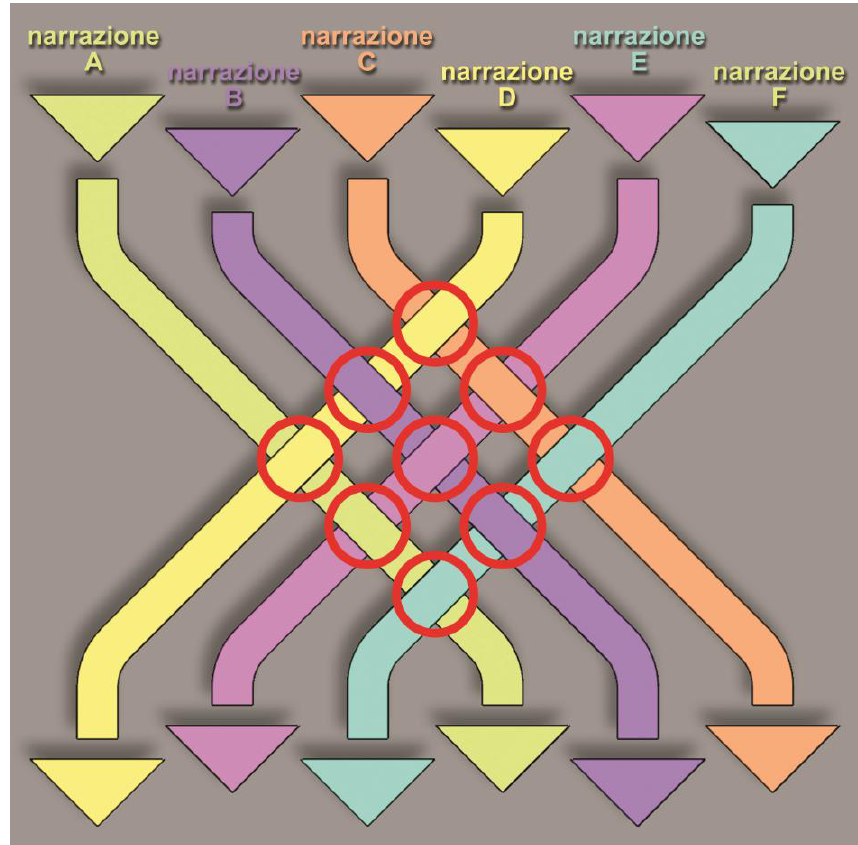
Figure 2. The diagram shows the possible relationships between the different narrations contemplated in the MUVAT site. The result is a portal with ever-changing